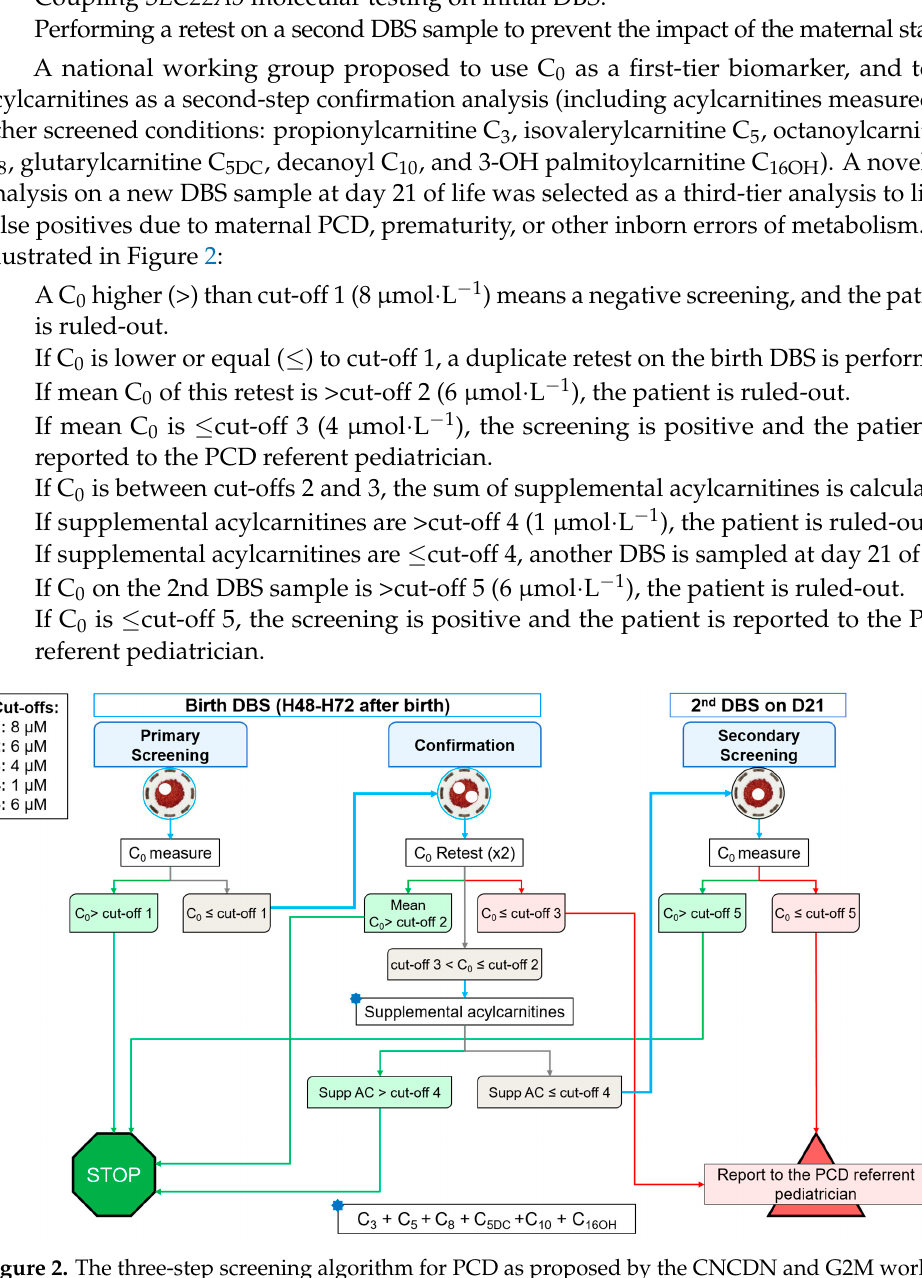
Figure 2. The three-step screening algorithm for PCD as proposed by the CNCDN and G2M working group. Cut-offs are set for the method using underivatized-based sample preparation.